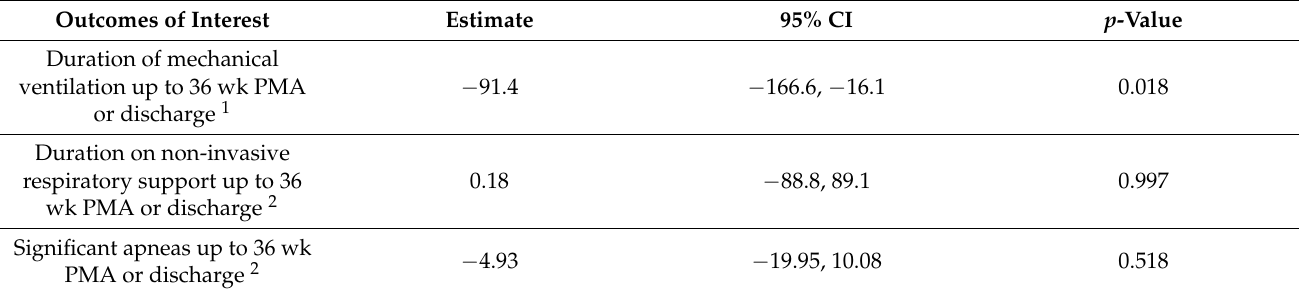
Table 2. Linear Regression models for outcomes of interest (prophylactic high-dose vs.